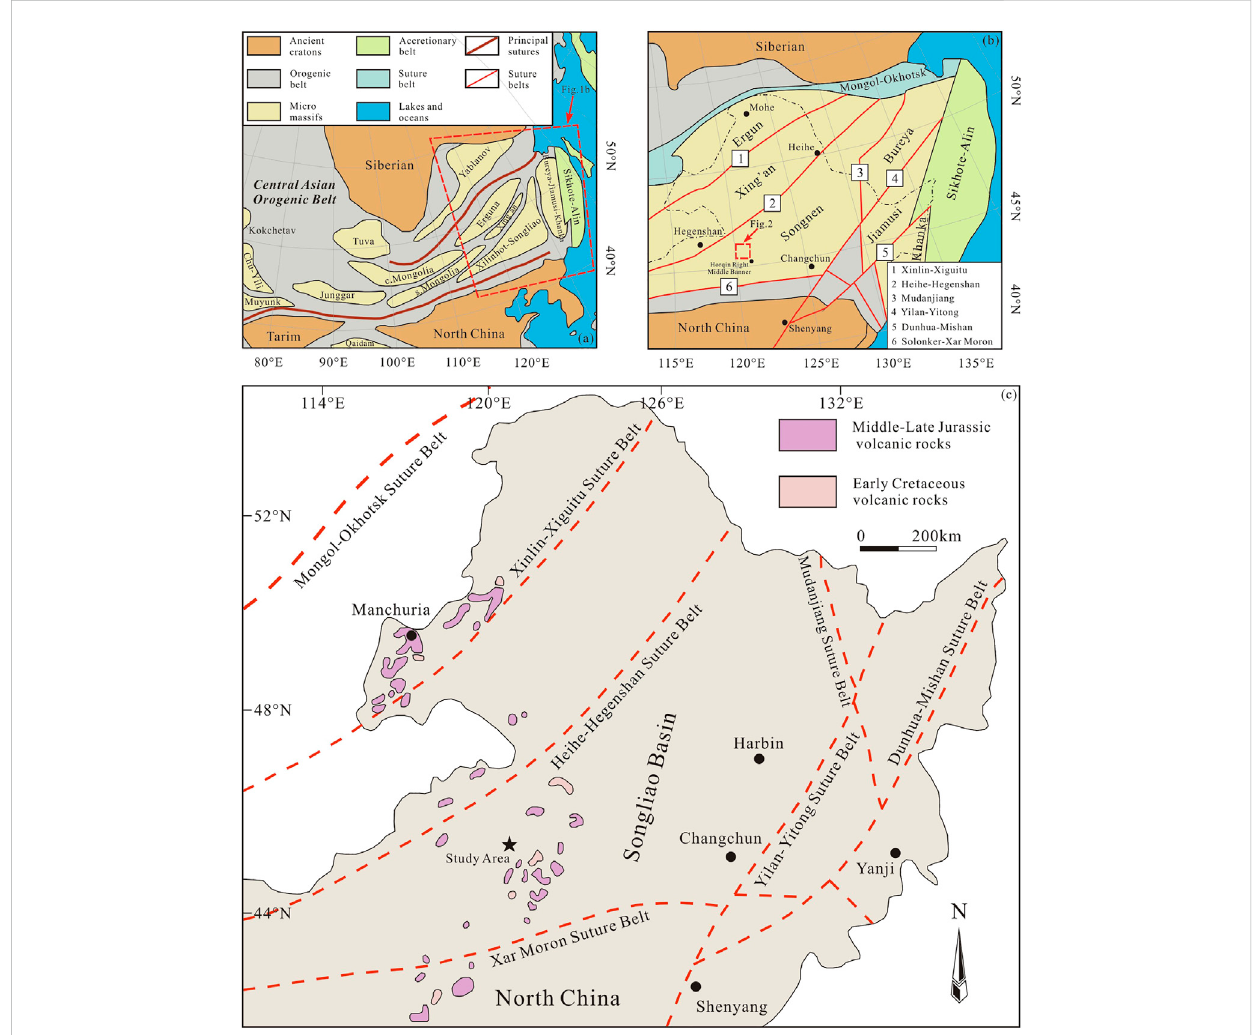
FIGURE 1 (A) Tectonic framework of the North China – Mongolia segment of the Central Asian Orogenic Belt (adapted from Liu et al., 2017). (B) Simpli fi ed geological mapofNE China showing themaintectonicsubdivisions(adapted from Zhouet al.,2015a). (C) Distribution map(adapted fromXu etal., 2013) of Middle-Late Jurassic and Early Cretaceous volcanic rocks in NE